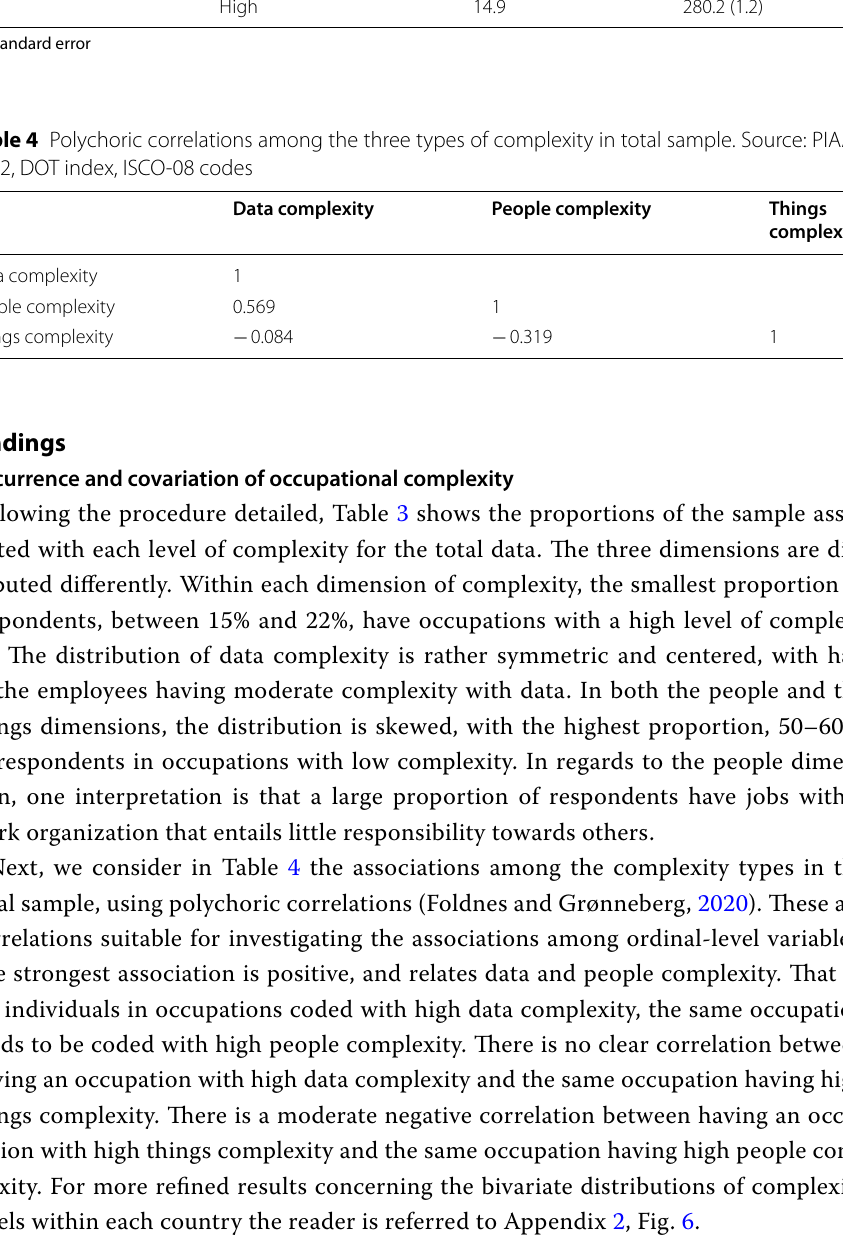
SE standard error